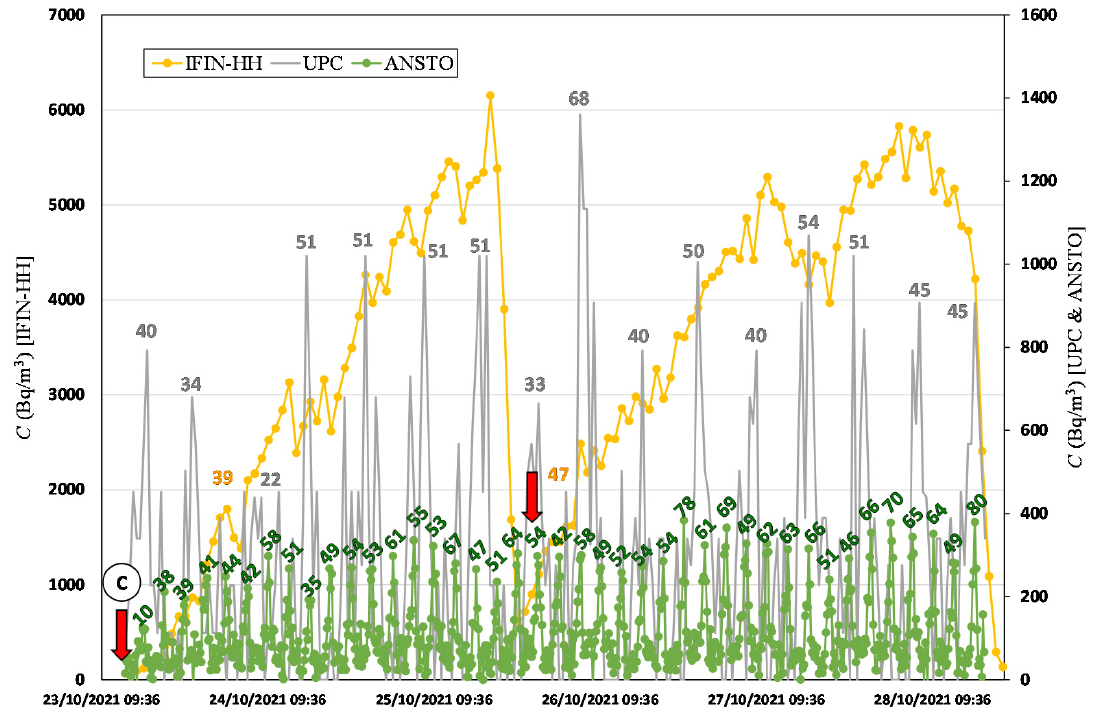
Figure 12. Radon activity concentration over time measured during the second week of the low radon flux area campaign. Colored numbers indicate the radon flux (Bq m − 2 h − 1 ) calculated by linear fitting.